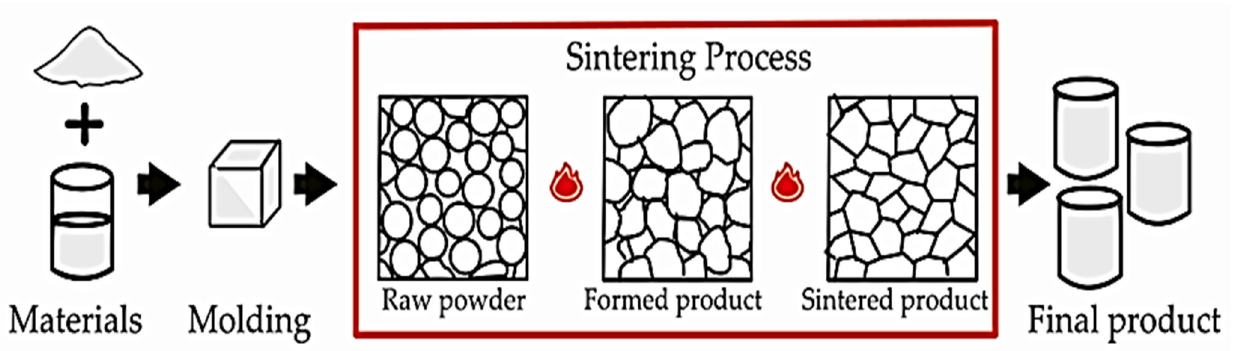
Figure 4. Sintering process flow.